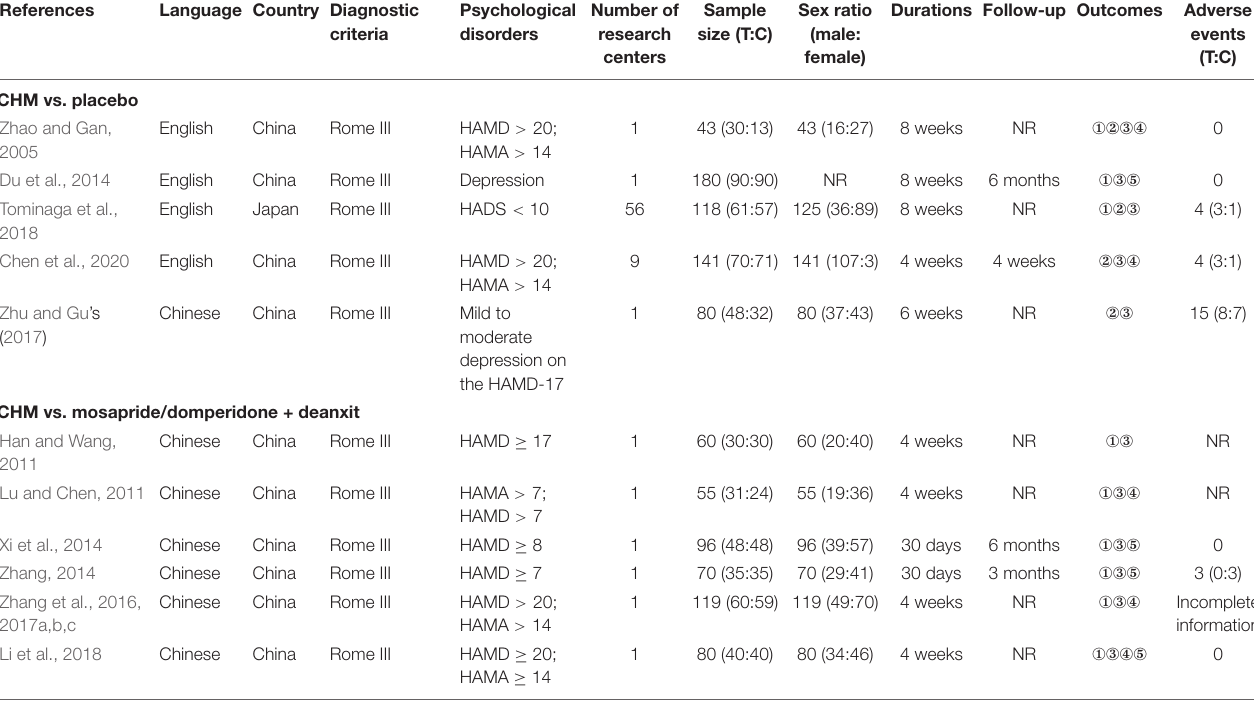
TABLE 1 | Basic characteristics of included